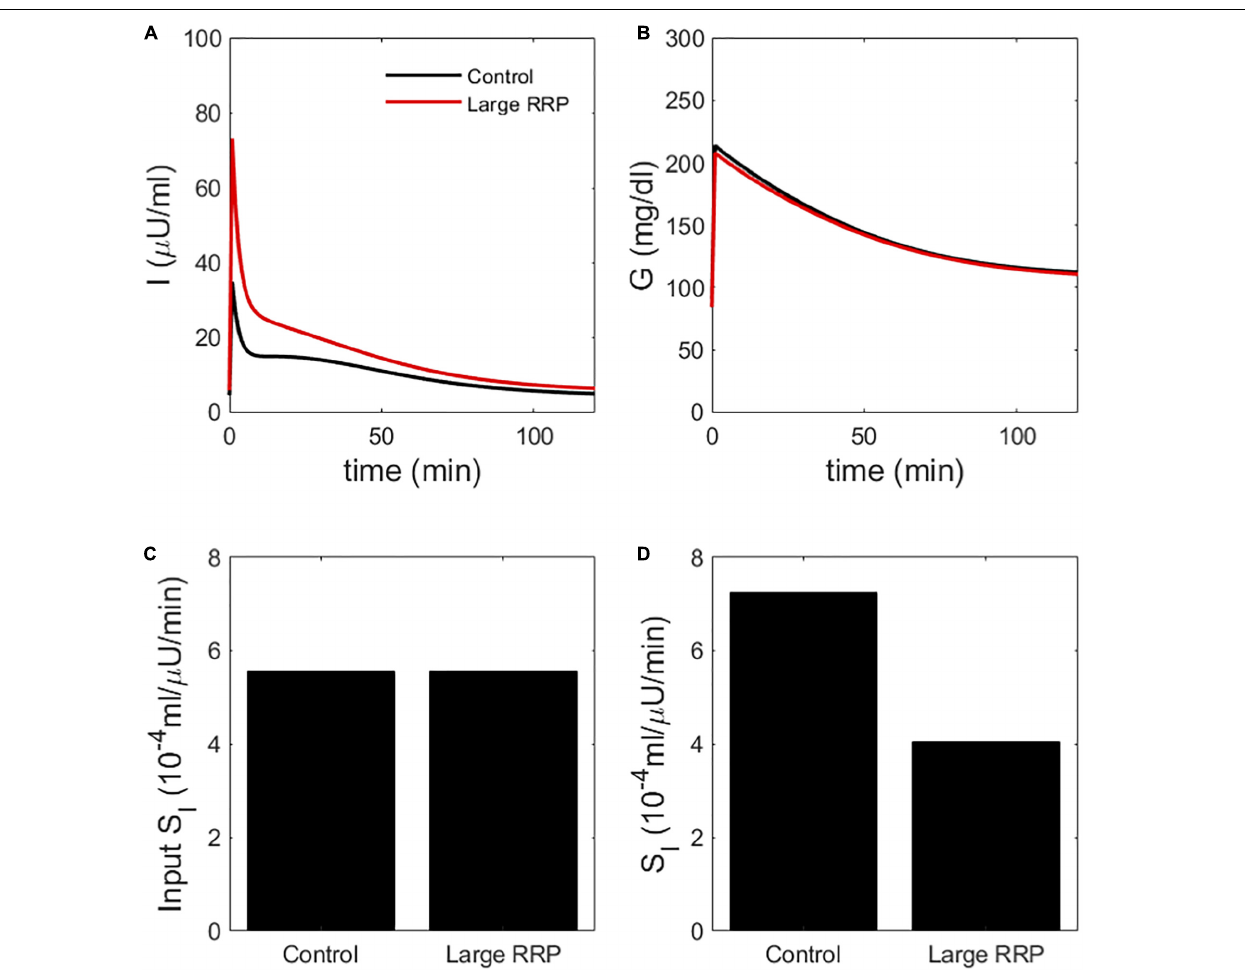
FIGURE 2 | (A) insulin and (B) glucose during a simulated IVGTT. The red traces represent a case of AIR increased by increasing the rate r 0 2 of vesicle priming in the synthetic model ( Figure 1 ). Although the assumed S I is the same (C), MINMOD reports a reduced value (D). Control and Large RRP cases differ as well in S G , which is adjusted to equalize basal glucose. See Table 1 for parameter values for this and subsequent figures.